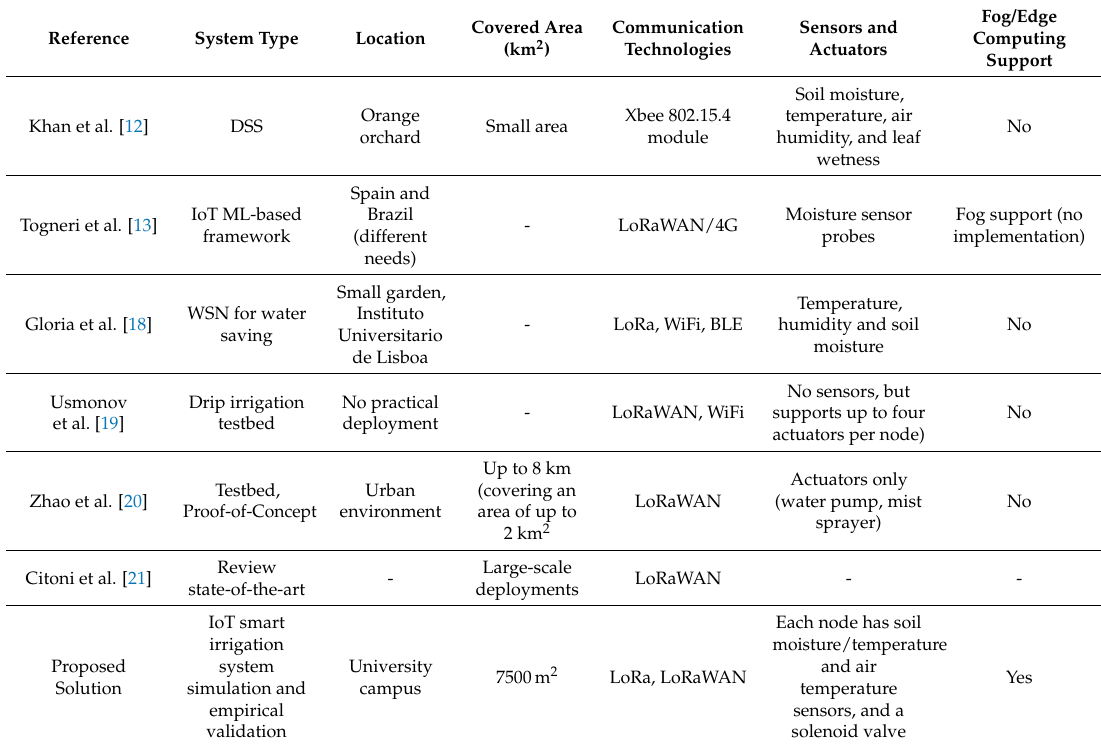
Table 2. Comparison of some of the features of the most relevant smart irrigation systems and the proposed